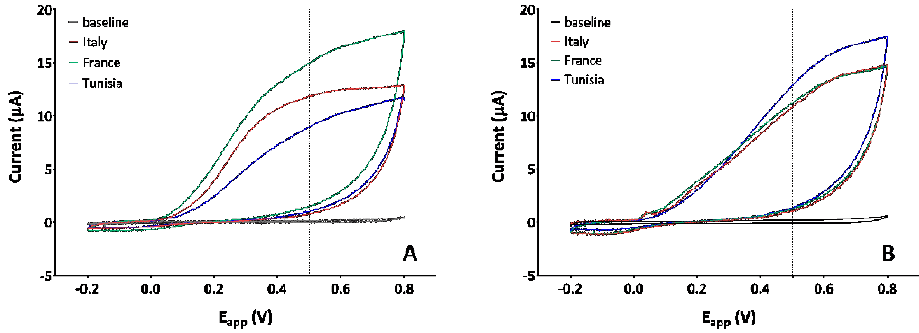
Figure 2. Cyclic voltammograms, with a scanned potential range (E app ) comprised between -0.2 V and +0.8 V vs. carbon pseudoreference, in the absence (PBS black line) and in the presence of 2 mg/mL of Italian (red line), French (green line), and Tunisian (blue line) pomace extracts of Syrah ( A ), and Chardonnay ( B ).